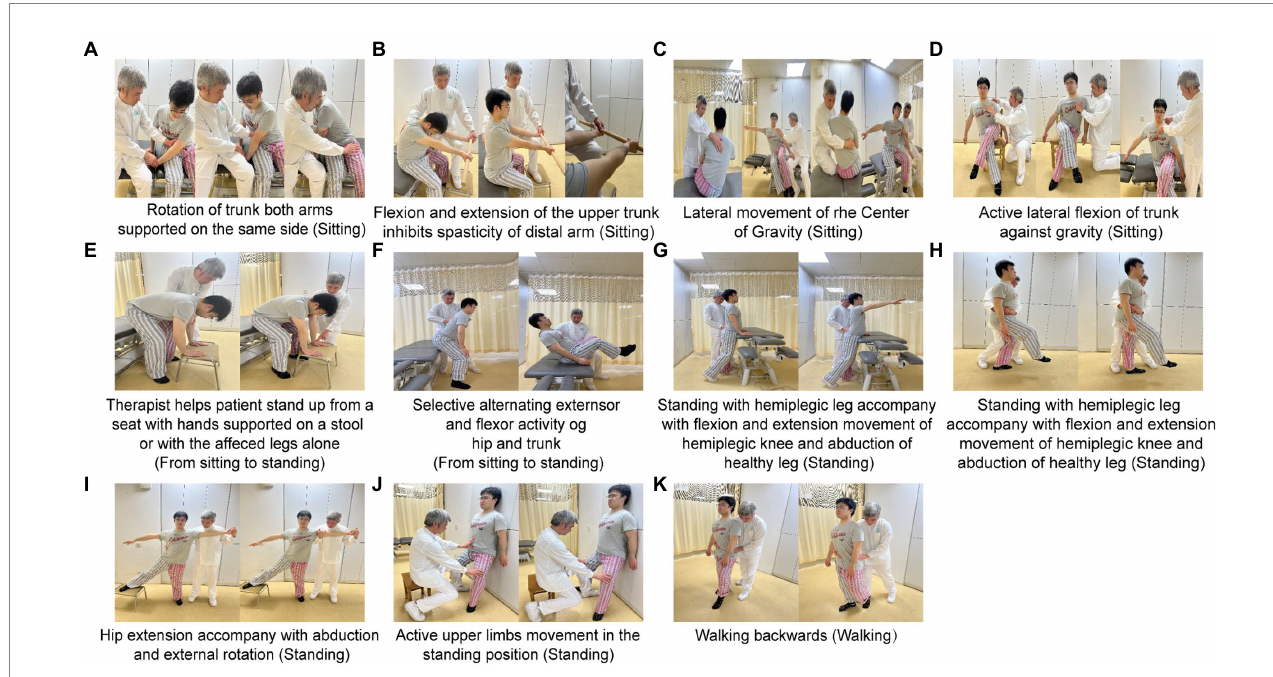
FIGURE 2 Control group (TSAT). Bobath training consists of four activities: sitting (A–D) ; sitting to standing (E,F) ; standing (G–I) : and walking (K) . Each activity includes selectively exercises the truck and